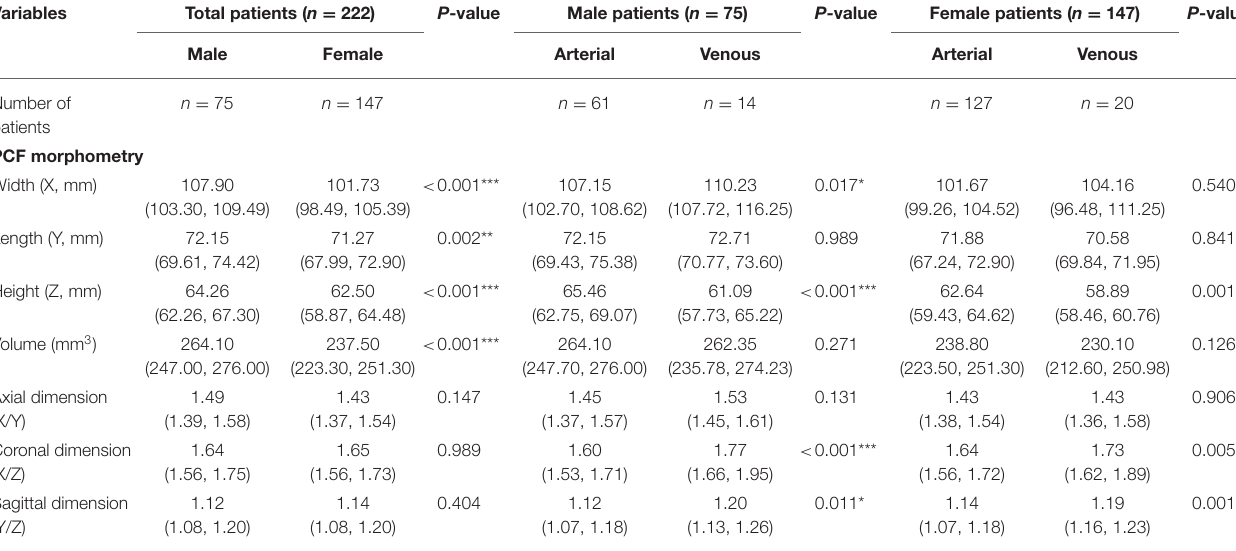
TABLE 3 | Sex-dependent PCF morphometric differences in classic TN patients caused by sole arterial or venous NVC. Variables Total patients ( n = 222) P -value Female Arterial Venous Arterial Venous Number of